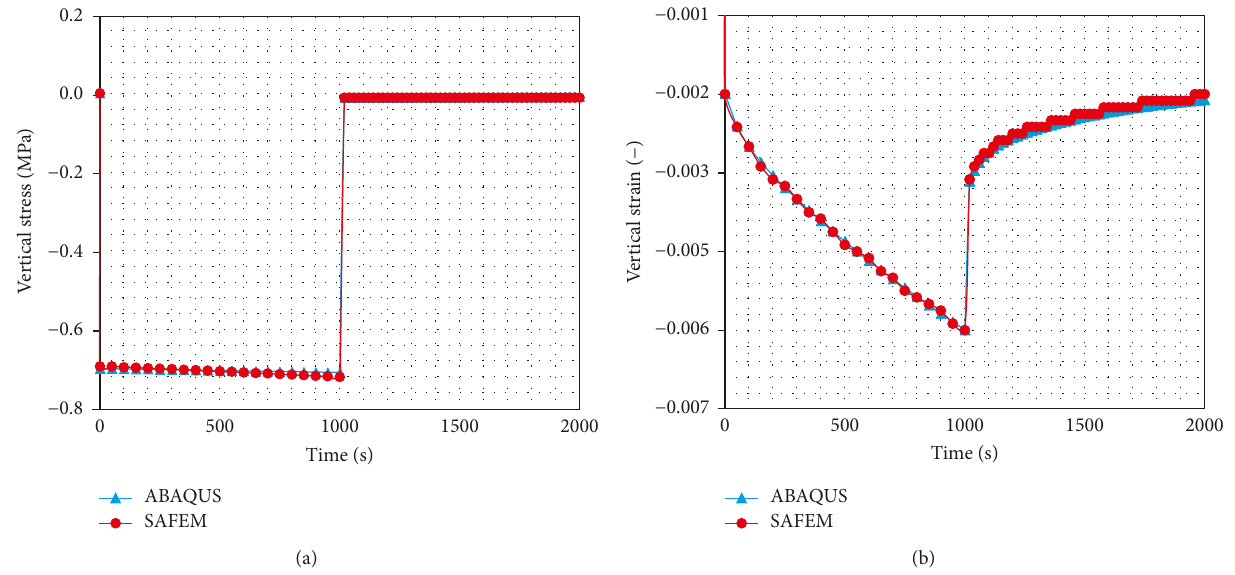
Figure 8: Comparison of (a) vertical stresses and (b) vertical strains at the center of the pavement surface between ABAQUS and